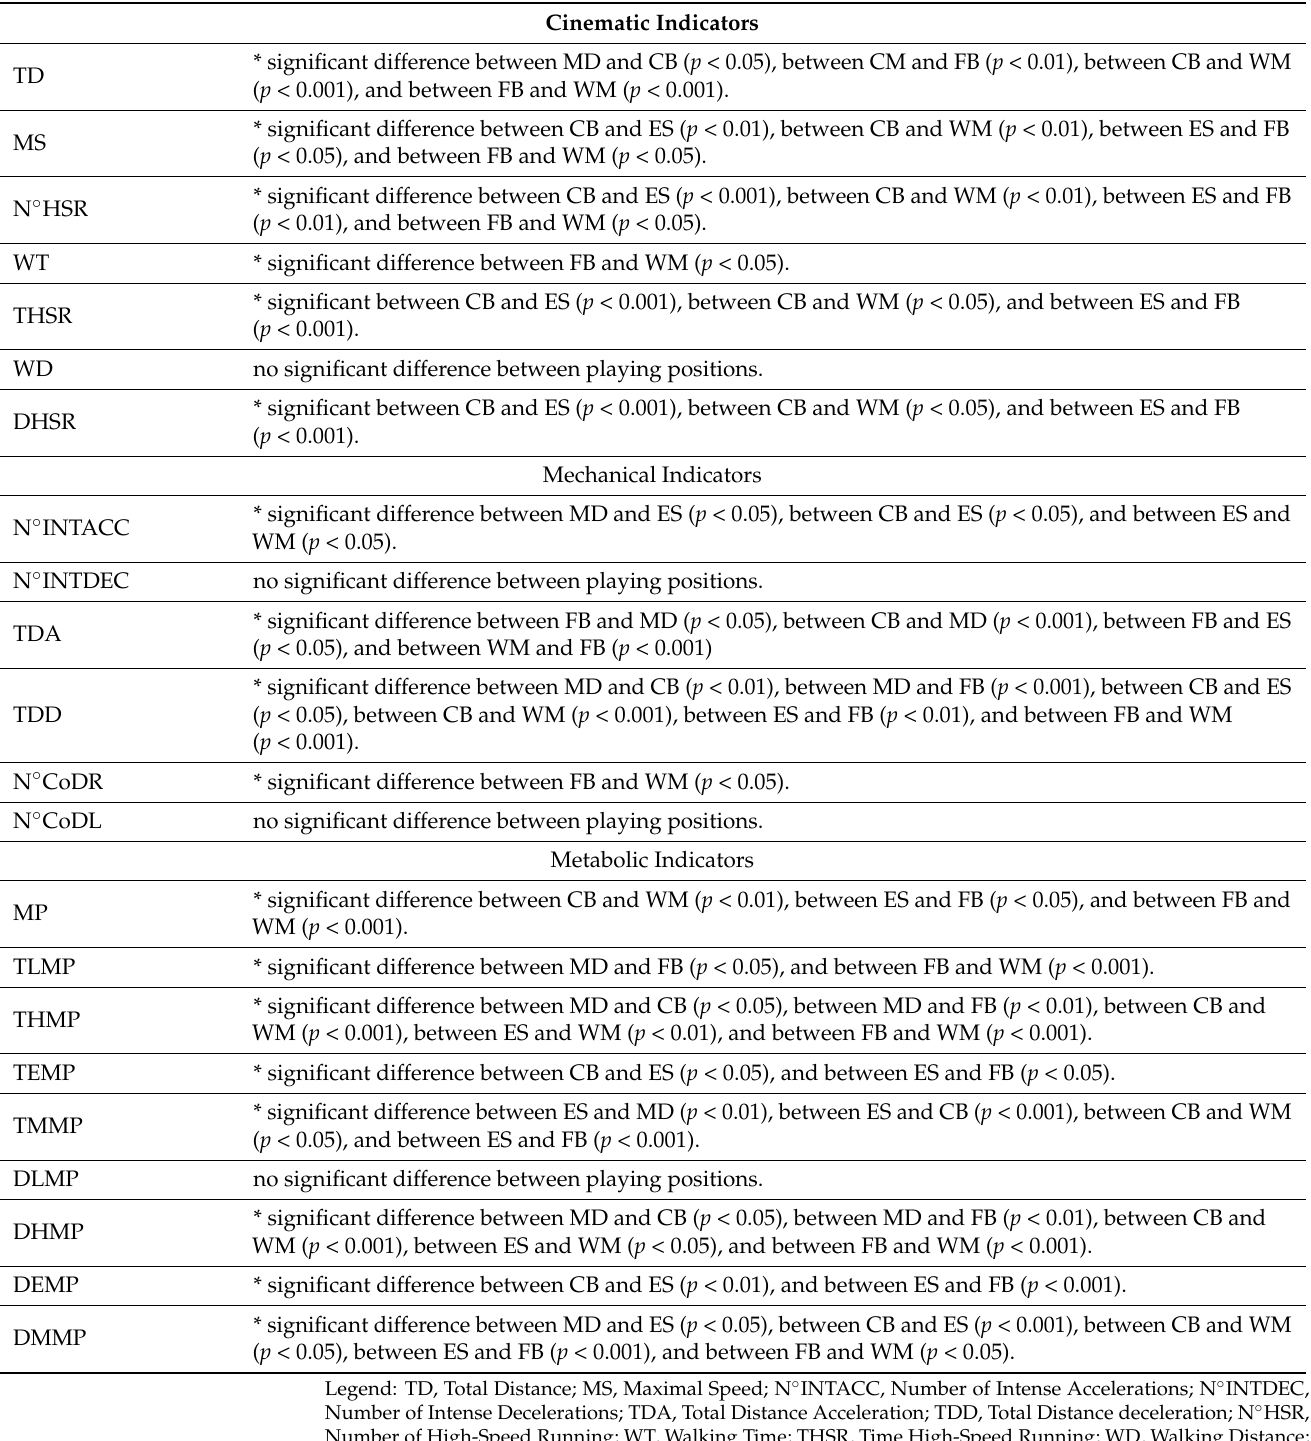
Table 7. Multiple comparison test results. Cinematic